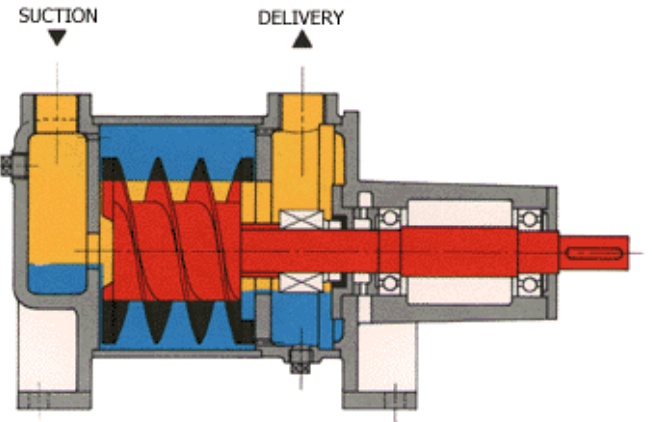
Figure 2. Schematic of a Liquivac pump (Reprinted with permission from ref. [13]. Copyright 2021 Wiley).